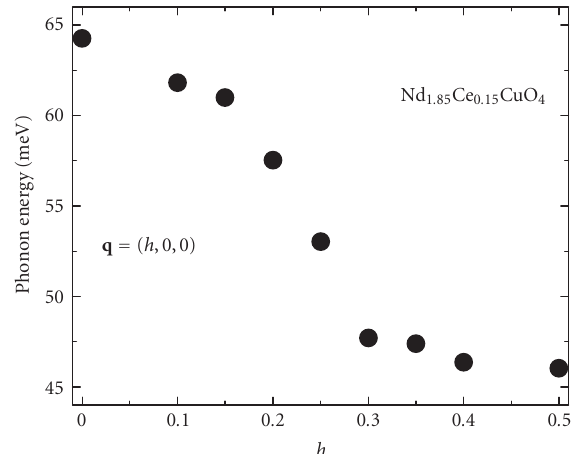
Figure 28: Dispersion of the Cu–O bond-stretching phonon in Nd 1 . 85 Ce 0 . 15 CuO 4 adapted from